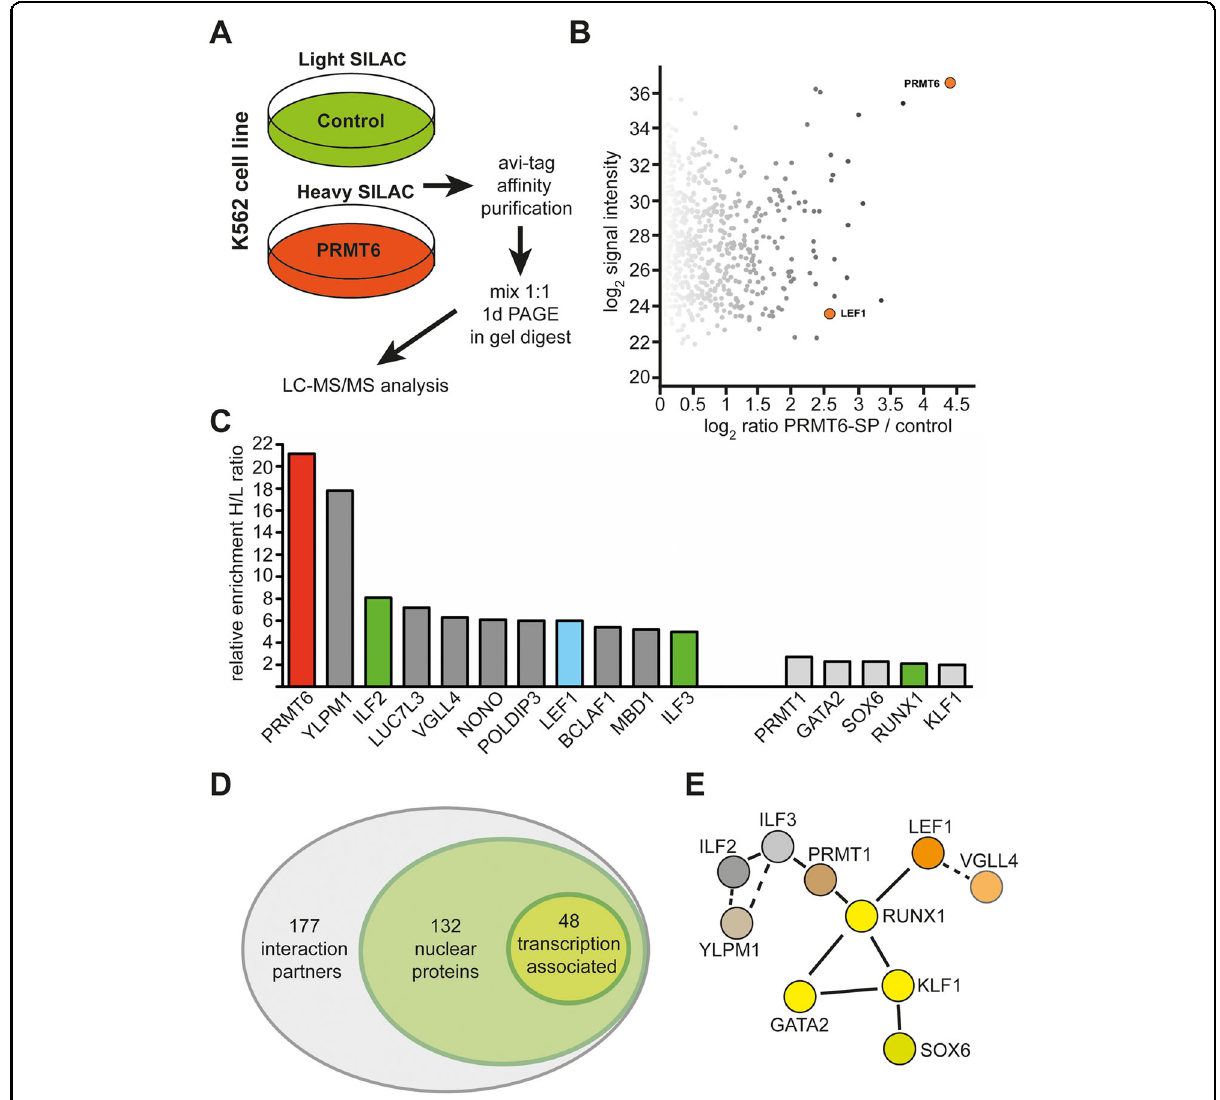
Fig. 2 SILAC-based mass spectrometry reveals PRMT6 interactome. A Strategy for the identi fi cation of PRMT6 interaction partners by SILAC based mass spectrometry upon avi-tag af fi nity puri fi cation of PRMT6. K562 cells were transduced with PRMT6 and the corresponding empty pRRLs- Avi vector control. The control cells were cultured for seven passages in light SILAC medium, containing normal amino acids, avi-PRMT6 over expressing cells were cultured in heavy SILAC medium (amino acids labeled with heavy isotopes). Nuclear extracts were prepared, and avi-tag af fi nity puri fi cation was performed with streptavidin beads. The extract form light and heavy SILAC labeled cells were mixed in a 1:1 ratio and applied to LC- MS/MS analysis. B Scatter plot of signaling intensity vs. PRMT6-SP/control. PRMT6 and LEF1 are highlighted in orange. C Selected candidate interaction partners of PRMT6. Known interaction partners are marked in green. Relative enrichment of proteins in the bio-PRMT6 sample was determined by calculating the ratio between peak intensities of identi fi ed peptides from the heavy (H, bio-PRMT6 + BirA-ligase) versus the light (L, BirA-ligase) sample. The cut-off was enrichment with an H/L ratio of two (which is KLF1). D Euler diagram of PRMT6 interactome. Functional annotation clustering with DAVID 8,9 revealed that most interacting proteins are nuclear located and 48 are associated with transcription. E Protein interaction network of transcription factors and associated cofactors revealed by STRING 10